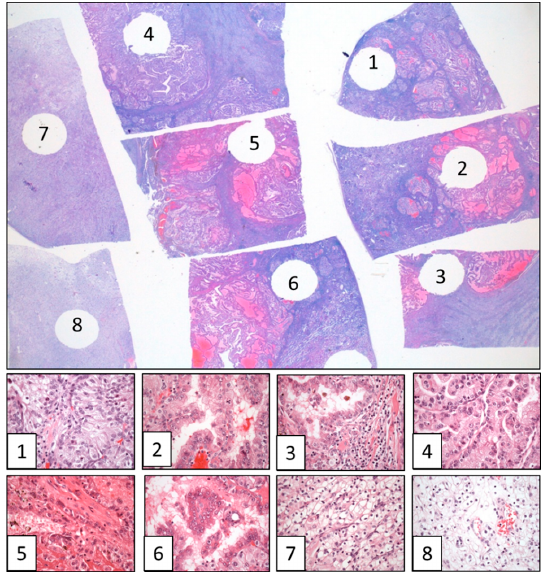
Figure 2. Multisite tumor sampling example in a clear cell renal cell carcinoma (CCRCC) showing the varied spectrum of histologies detected across the eight selected fragments in a single paraffin block, with clear cell high grade phenotype in sample 1, papillary eosinophilic in samples 2, 3, 4 and 6, solid eosinophilic in sample 5, and clear cell low grade in samples 7 and 8. (Hematoxylin & Eosin, original magnification, × 1.5 (large figure) and × 400 (figures 1 to